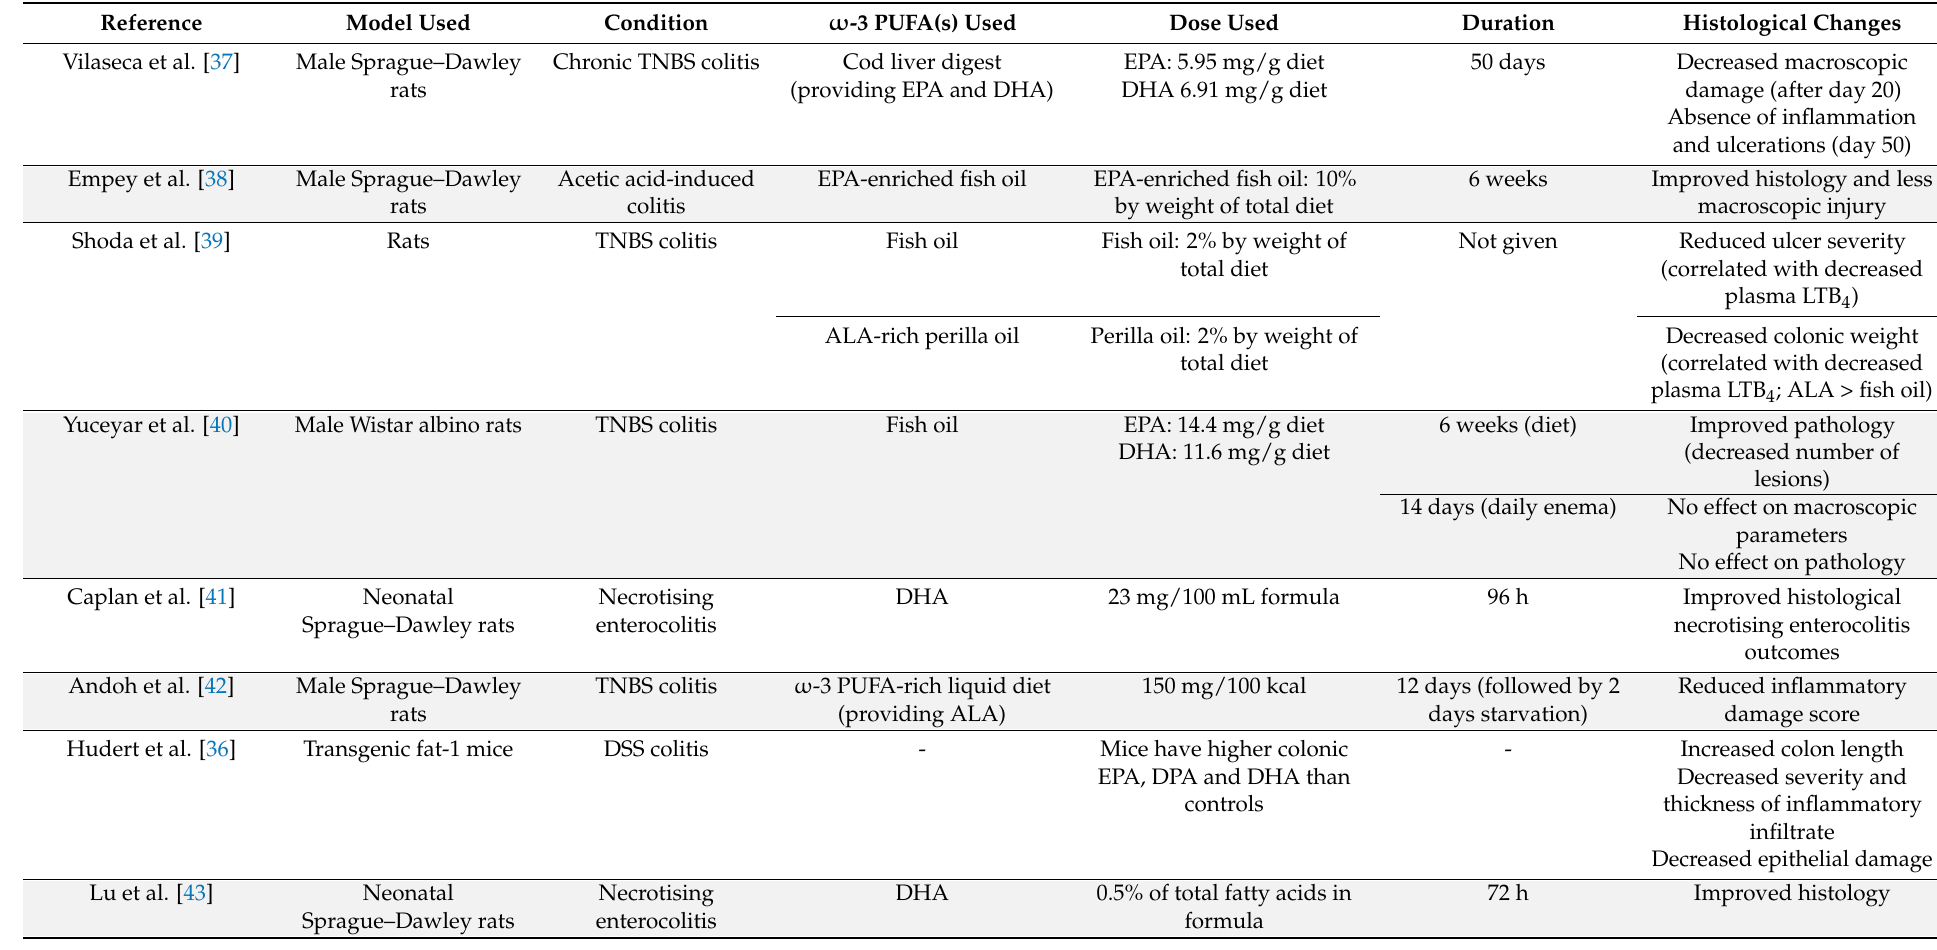
Table 3. Effects of ω -3 PUFAs on intestinal histology in rodent